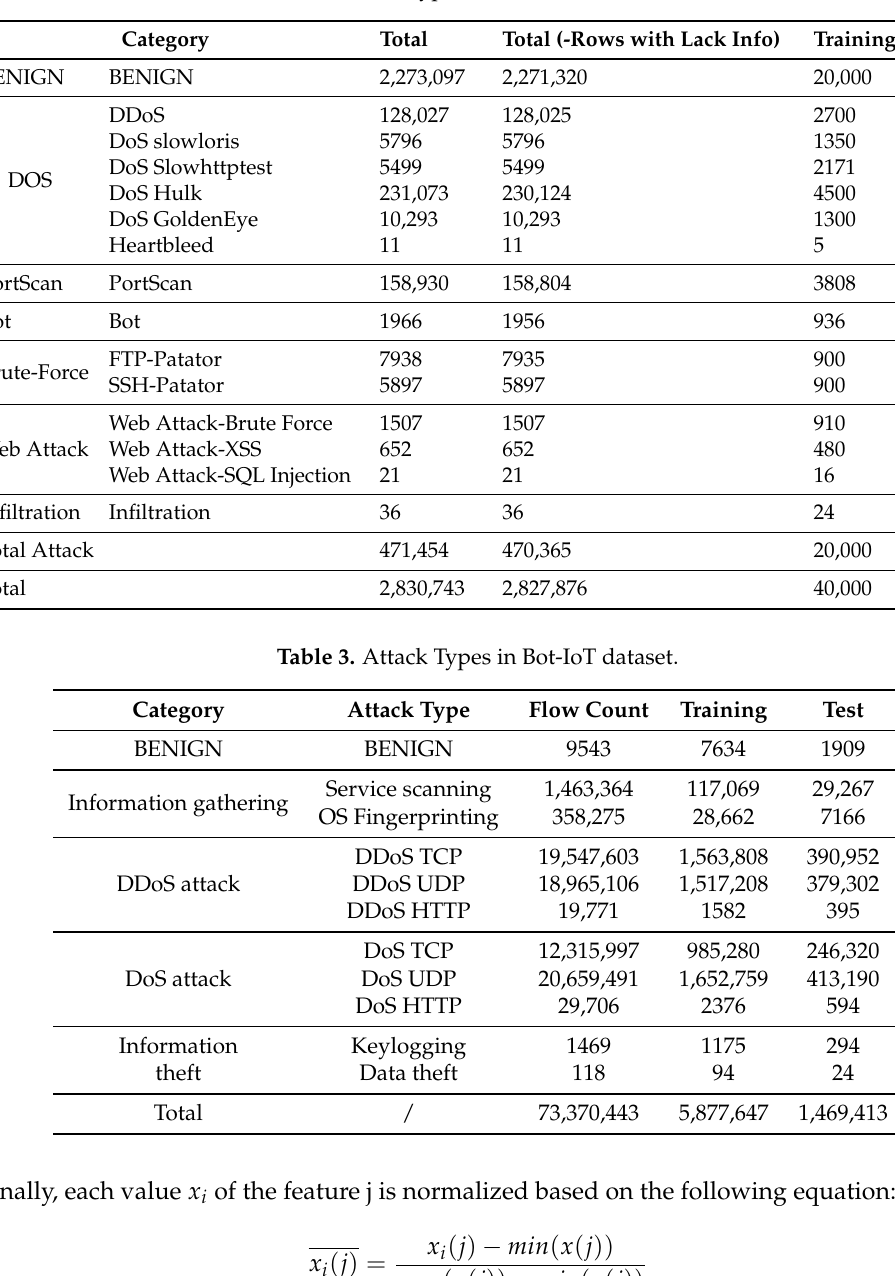
Table 2. Attack Types in CICIDS 2017 dataset.